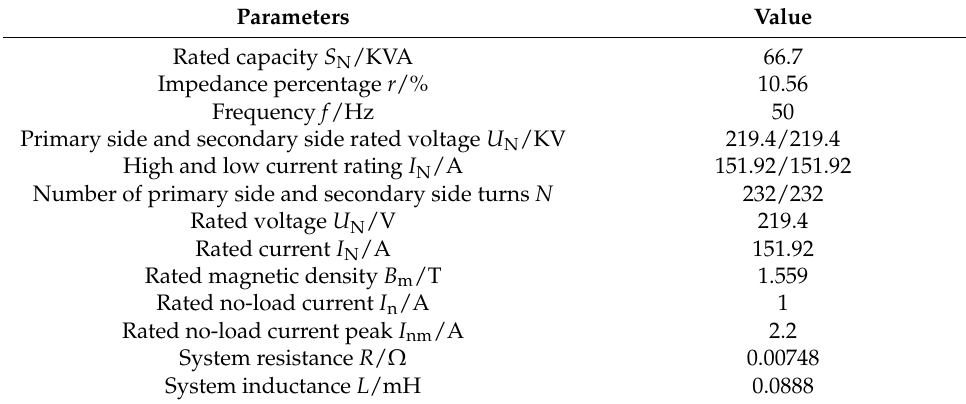
Figure 8. The circuit simulation model of a single-phase transformer with no-load closing. The research presented in this paper is a continuation of our previous work [26]. The parameters of the test transformer are shown in Table 1. To ensure that the simulation results are as close as possible to the actual values, the parameters of the prototype need to be transformed into those of the specific module, and the hysteresis characteristics of the core material, i.e., the i - ϕ curve, must be taken into account. Table 1. Transformer test prototype main parameters.